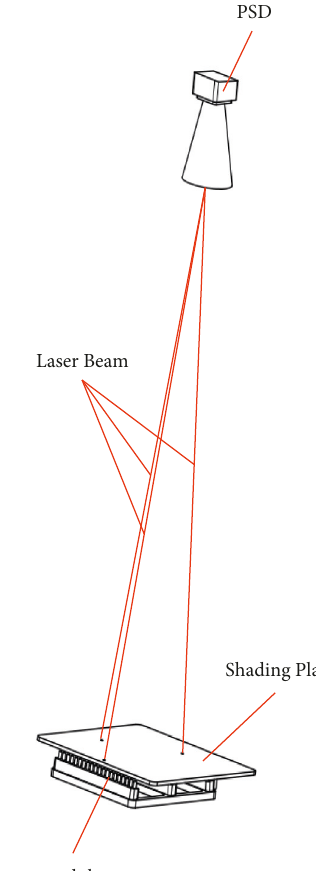
Figure 5: Schematic diagram of the laser module array emission